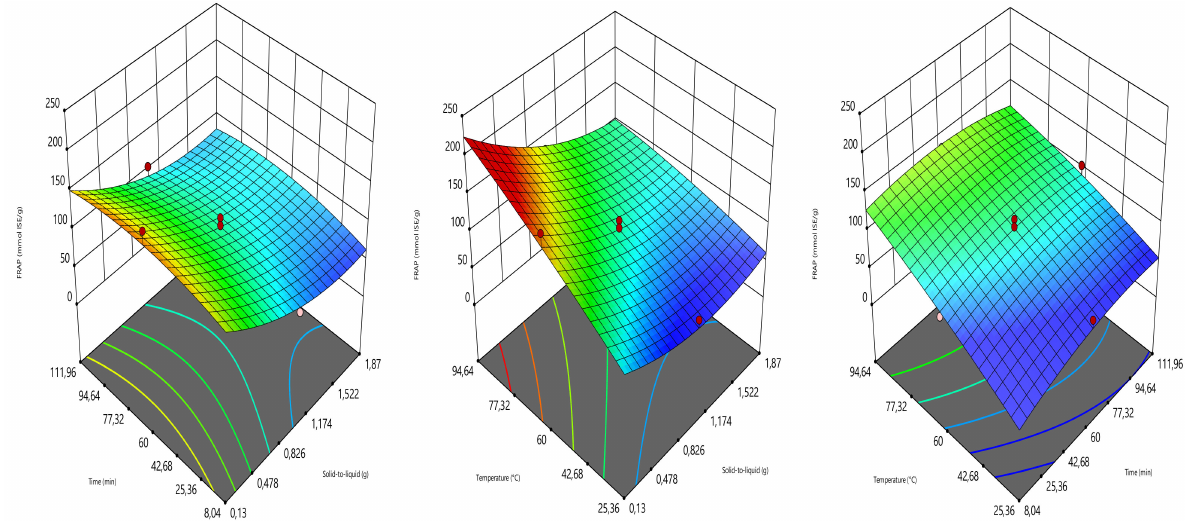
Figure 5. Three-dimensional graphics showing the effects of the independent variables on